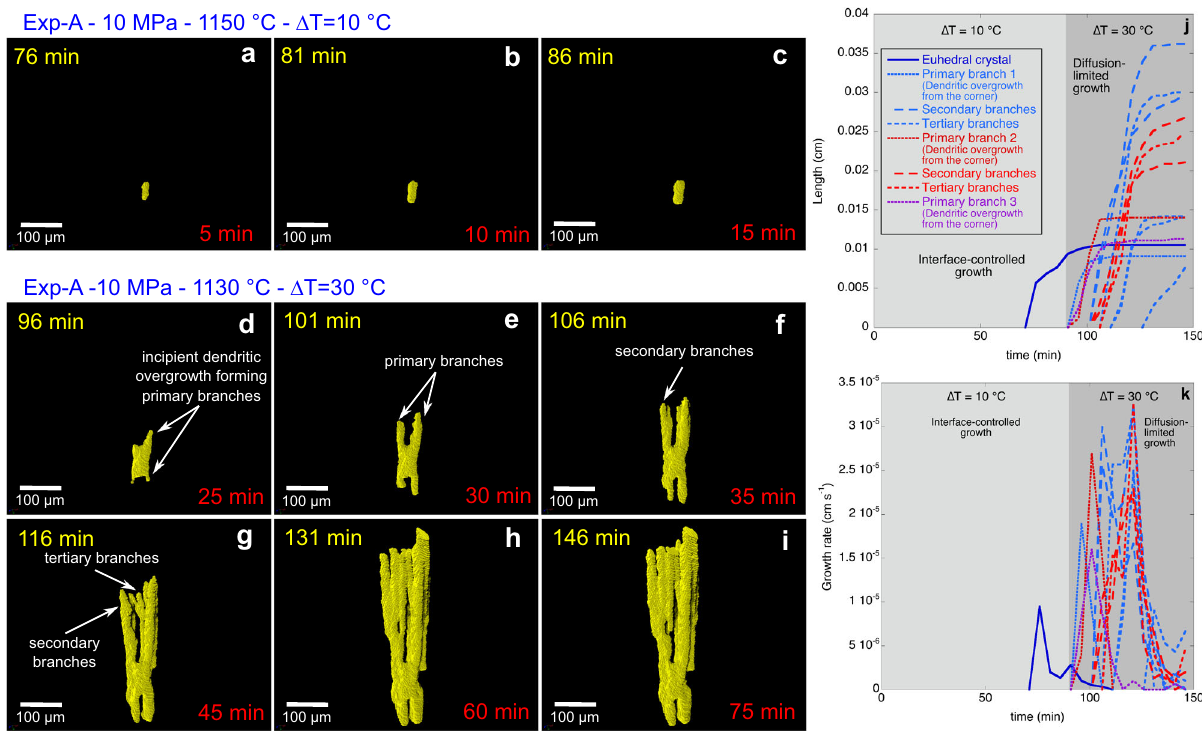
Fig. 3 Crystallisation and crystal shape evolution of a clinopyroxene crystal through time during the experiment Exp-A. a – c Volume renderings show the growth of a euhedral clinopyroxene crystal through time at 1150 °C and Δ T = 10 °C. d – i Volume renderings show the transition between euhedral to dendritic shapes and the growth of a dendritic clinopyroxene crystal through time at 1130 °C and Δ T = 30 °C. The formation of primary branches indicates the transition from an interface-controlled growth to a diffusion-limited growth ( d , e ). Secondary ( f ) and tertiary ( g ) branches are formed through time under diffusion-limited growth. j Evolution of the maximum length (along c axis) of a clinopyroxene crystal through time at Δ T = 10 °C and Δ T = 30 °C. k Growth rate of a clinopyroxene crystal as a function of time at Δ T = 10 °C and Δ T = 30 °C. a – k The undercoolings ( Δ T ) investigated are calculated with respect to the clinopyroxene liquidus. a – i The time in yellow reported in each panel indicates the time passed from the beginning of the experiment. The time in red reported in each panel indicates the time passed from the formation of the pyroxene